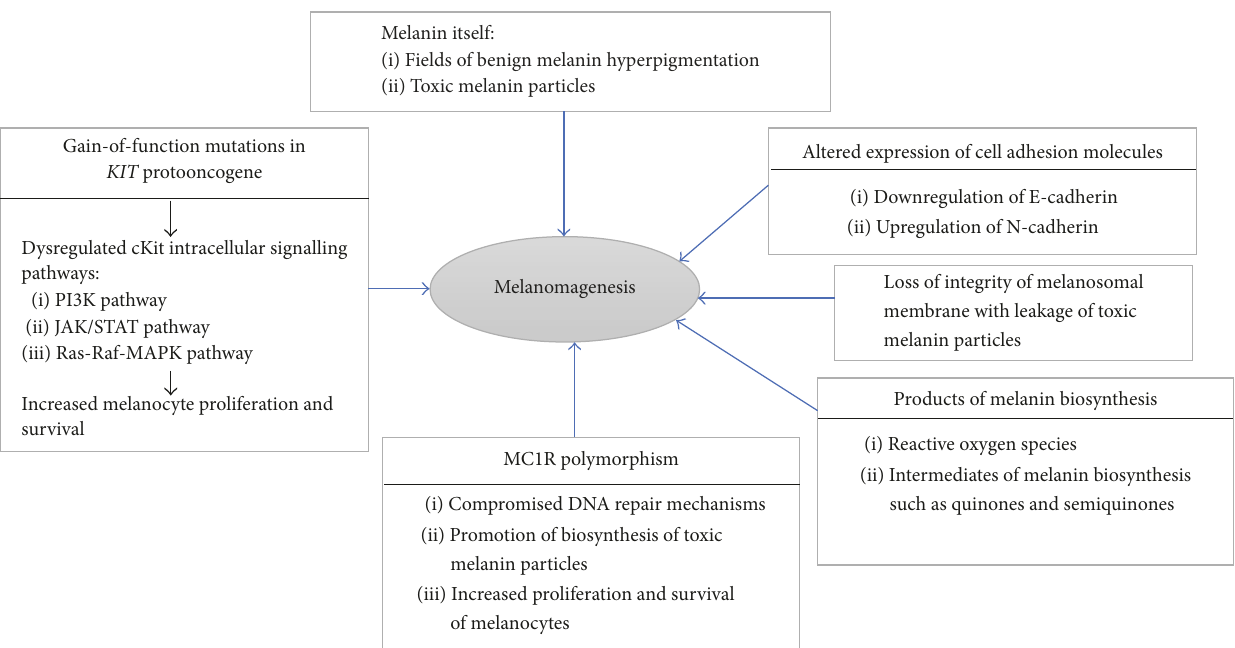
Figure 1: Mechanisms of melanomagenesis of oral mucosal